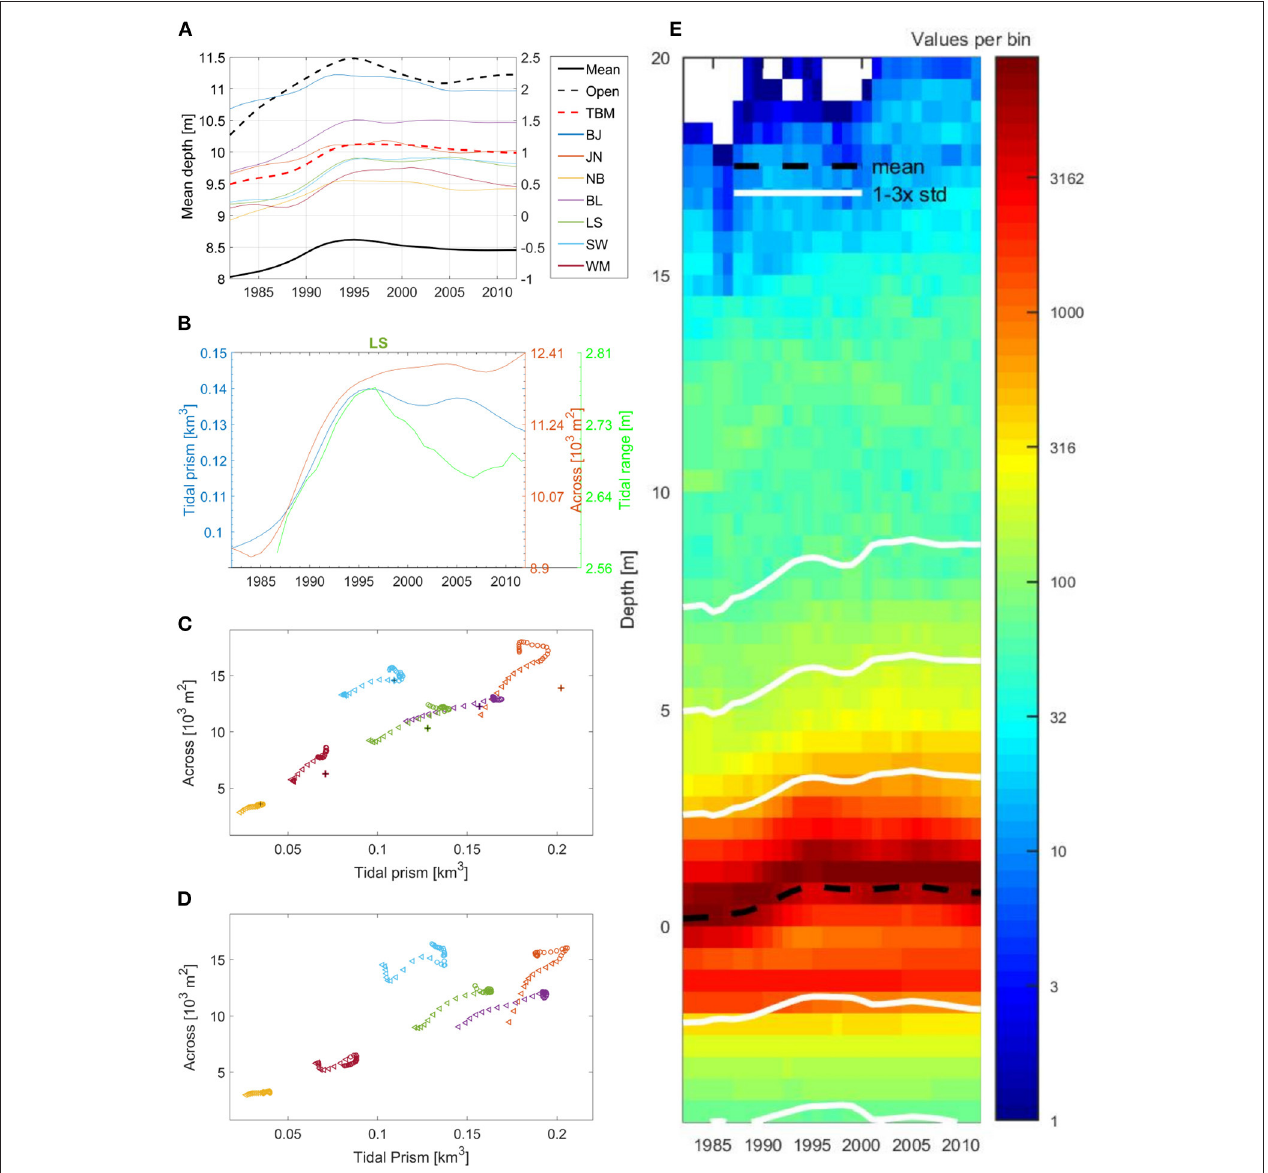
FIGURE 2 | (A) Mean depth (left y-axis) in the area covered by the AufMod data (thick black line) and in the open ocean (thick black dashed line; see Figure 1B for the definition of “open ocean”). The mean depths of individual tidal basins (right y-axis) are shown with colors (see legend and Figure 1B for their definition). The tidal basin mean (TBM) is shown with the thick red dashed line (right y-axis). (B) Tidal prism (blue), cross-sectional area of the Otzumer Balje (red), and tidal range (green; see Figure 1B for the positions of the tidal gauges). The tidal range used to compute the tidal prism is taken as 2.4 m, which is approximately the mean value in front of the NFWS. (C) Scatter plots showing the cross-sectional areas of the individual tidal basins vs. the corresponding tidal prisms. The colors for the individual tidal basins are the same as in (A) . Triangular symbols are used for the period 1982–1993. After 1993, circular symbols are used. The + symbols show the changes in 1993 if a uniform deepening of 0.56 m is specified after 1982. (D) Is the same as (C) , however the cross-sectional areas and tidal prisms are computed from the numerical model. (E) Shows the vertical distribution of depths (log scale) in the LS area presented as a function of the number of samples per individual depth-time bins. Bins are 0.5 m times 1 year big. The black dashed line shows the mean depth and the white lines show ranges of 1–3 standard deviations. This presentation is stretched in order that the curve of the mean value approximately corresponds to the respective curve of LS area in (A) .